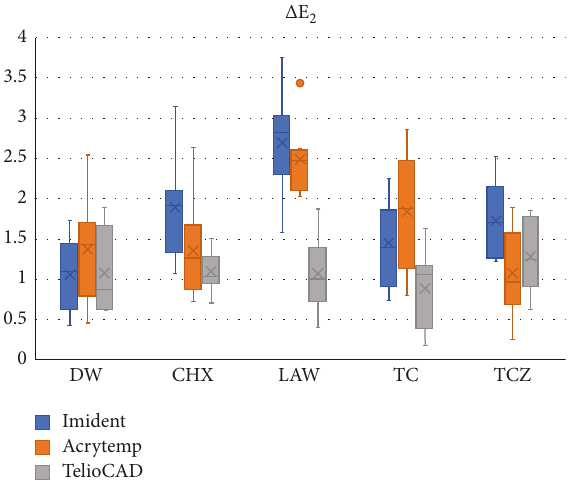
Figure 2: Δ E 2 values after